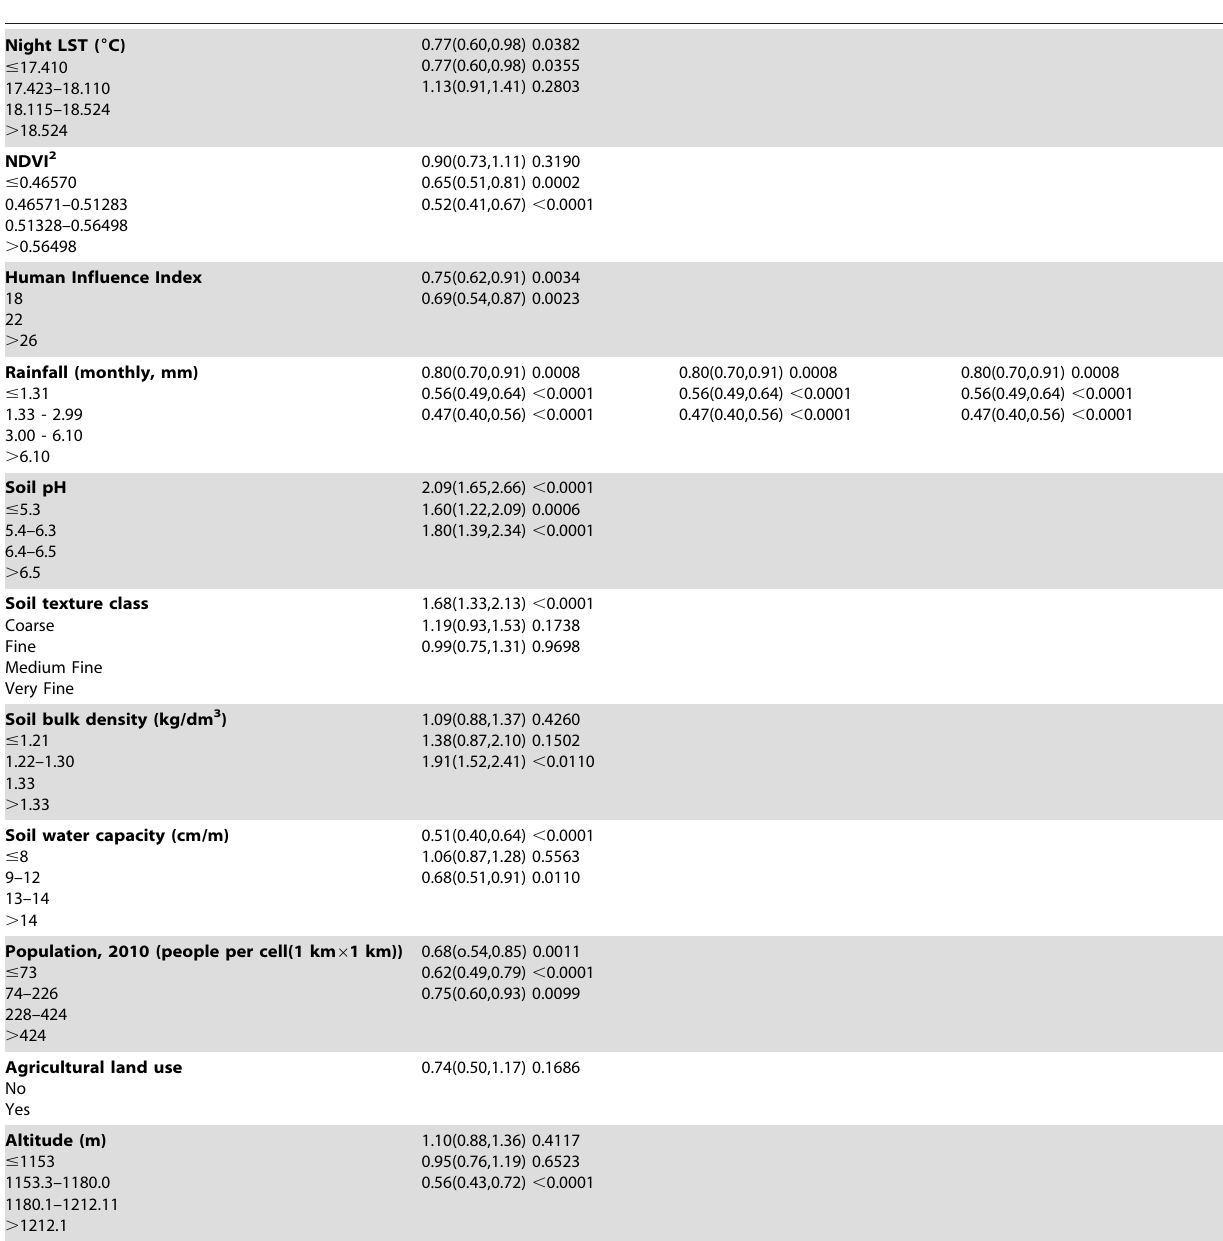
Table 1. Results of univariable and multivariable Poisson regression analyses for S.mansoni summarized by prevalence ratios (PR) and 95% confidence intervals